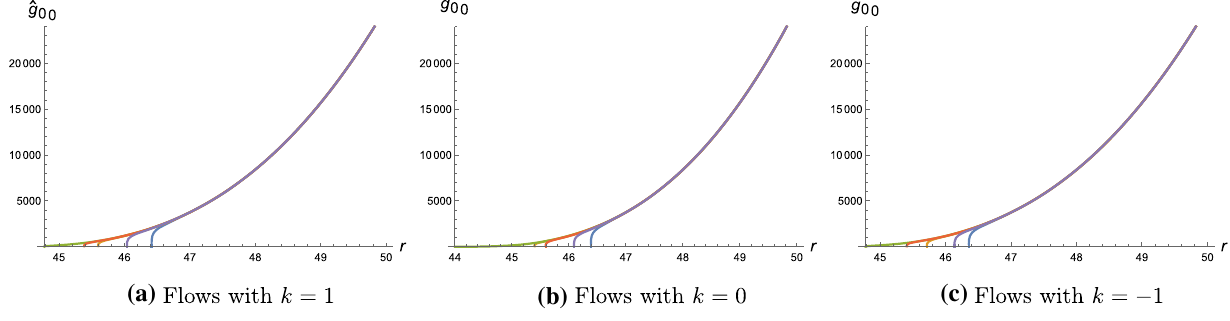
Fig. 34 Profiles of the ten-dimensional metric component ˆ g 00 for the supersymmetric flows given in Figs. 31, 32 and 33